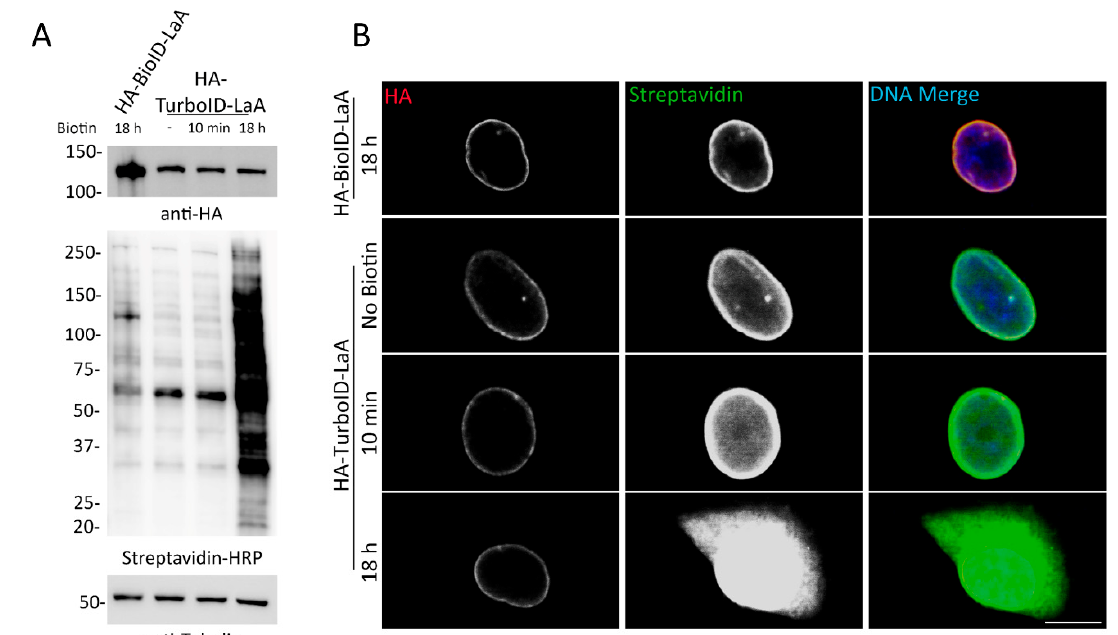
Figure 3. A549 cells stably expressing TurboID-LaA biotinylate without the addition of exogenous biotin. ( A ) Western blot analysis of HA-tagged BioID-LaA and TurboID-LaA fusion protein expression (anti-HA) and overall biotinylation (Streptavidin-HRP) without or after biotin supplementation for 10 min or 18 h. Anti-tubulin was used as a protein loading control. ( B ) Confocal images of A549 cells stably expressing HA-tagged BioID-LaA and TurboID-LaA. Anti-HA was used to visualize fusion protein localization (red). Fluorescently conjugated streptavidin was used to detect biotinylation following no biotin supplementation or addition of biotin for 10 min or 18 h. Hoechst dye was used to detect the DNA in the nucleus (blue in merge). Scale bar 10 μ m.